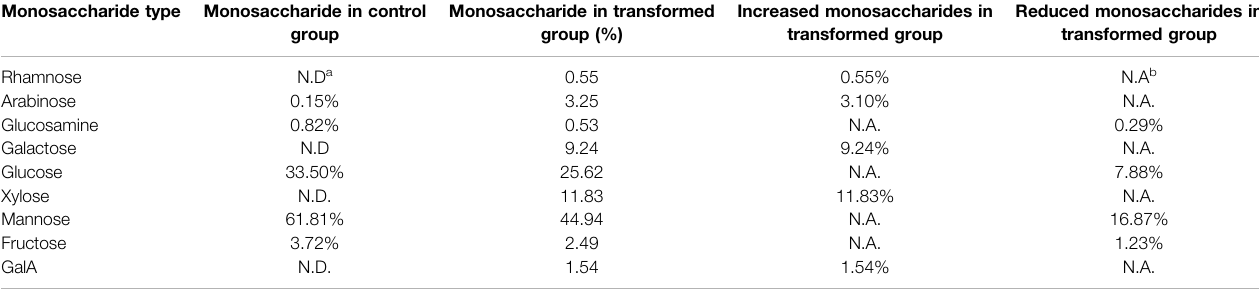
TABLE 2 | The proportion of monosaccharide composition in S. cerevisiae and its transformant on day 3. Monosaccharide type Monosaccharide in control